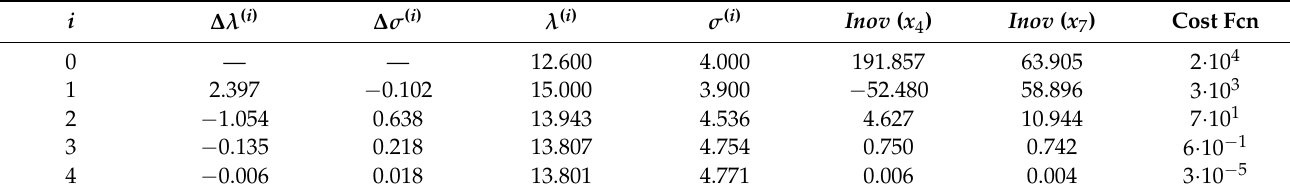
Table 3. FSM Iterates for λ = 12, Saltzman Scaling, Observations taken at t =